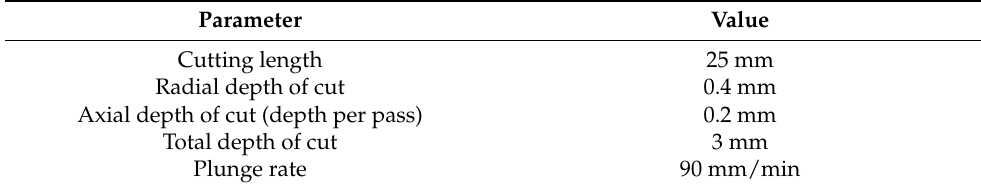
Table 5. The constant cutting conditions for high speed milling machining.